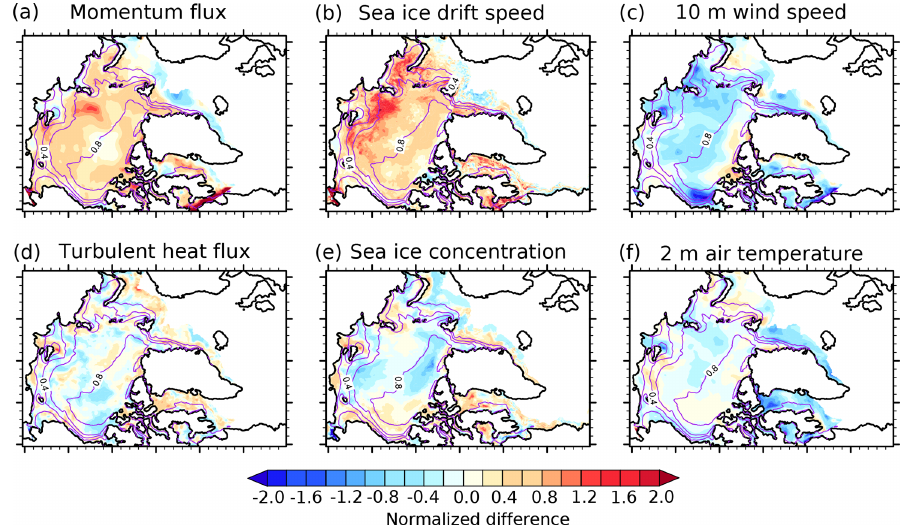
Figure 8. Normalized ensemble mean differences (SENS minus CTRL) of (a) momentum flux, (b) sea ice drift speed, (c) 10m wind speed, (d) turbulent heat flux, (e) sea ice concentration, and (f) 2m air temperature for the 2007 summer (JJAS). The ensemble mean difference is normalized by the cross-ensemble standard deviation of the differences. The purple contours represent the ensemble mean sea ice concentration in the CTRL experiment.